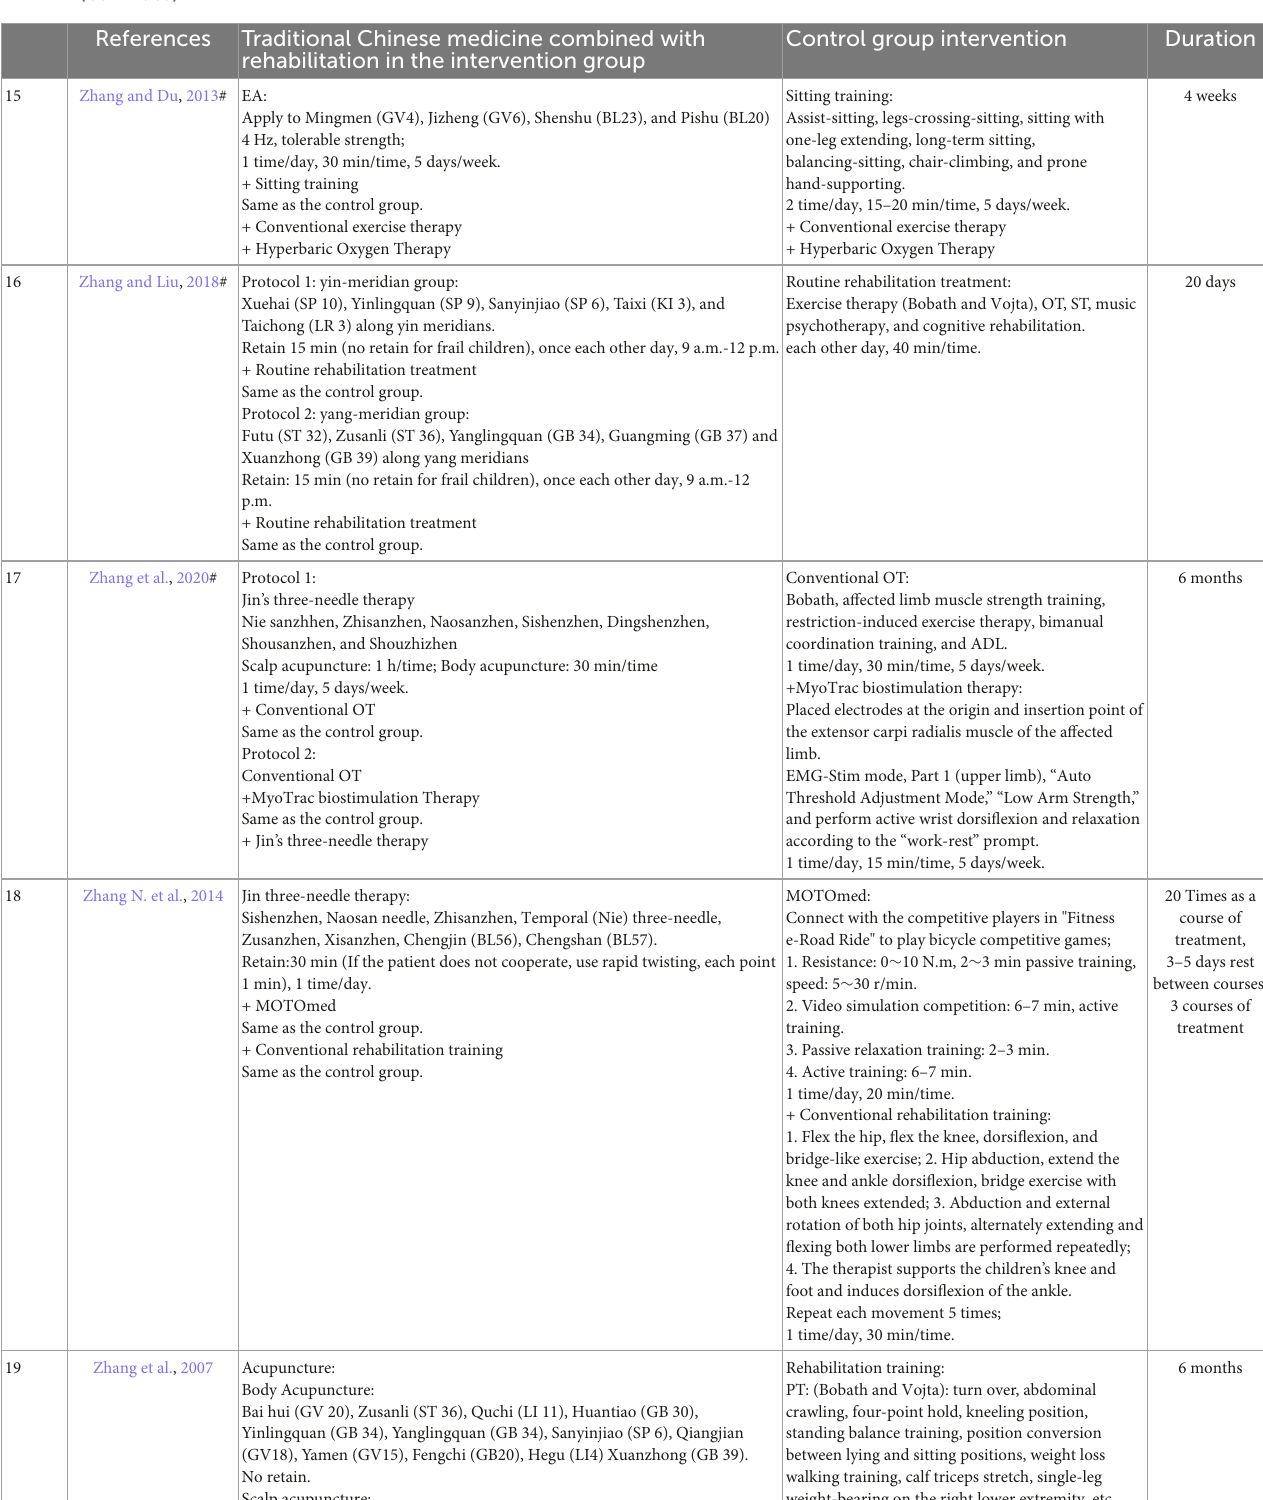
Protocol 2: yang-meridian group: Futu (ST 32), Zusanli (ST 36), Yanglingquan (GB 34), Guangming (GB 37)